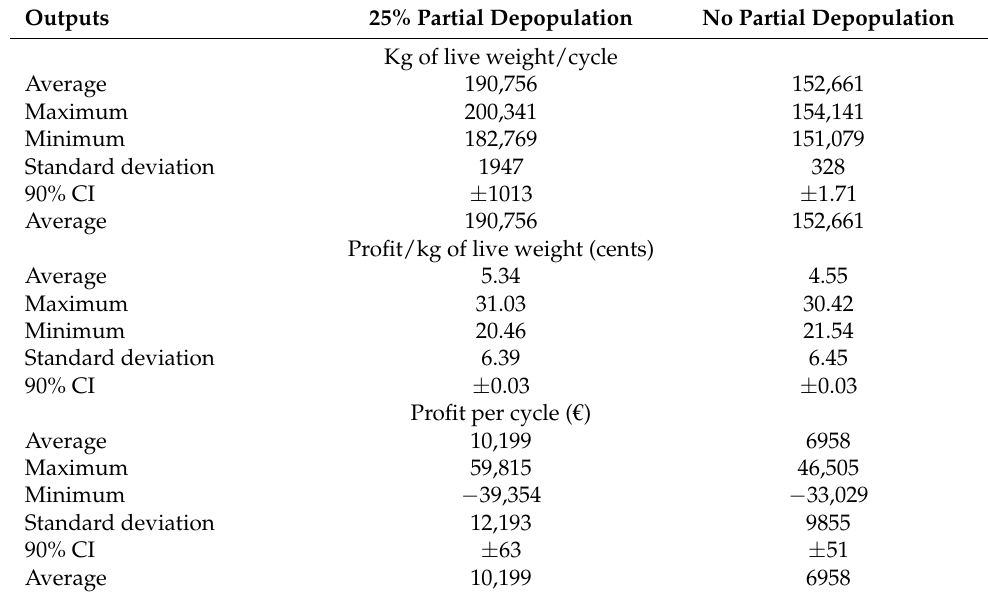
Table 3. Production and profit results in 25% partial depopulation scenario and no partial depopula- tion